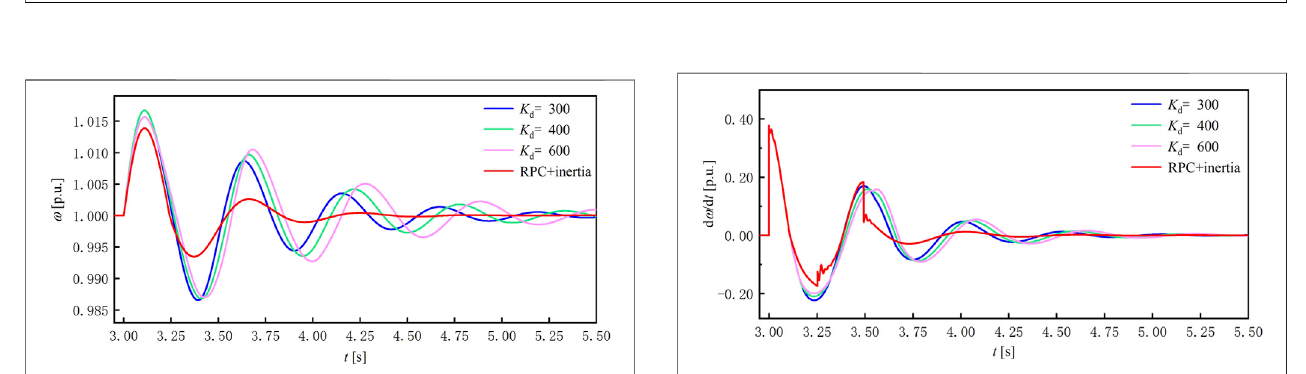
FIGURE 9 | Three-phase output current of VSC2 under different droop control modes.